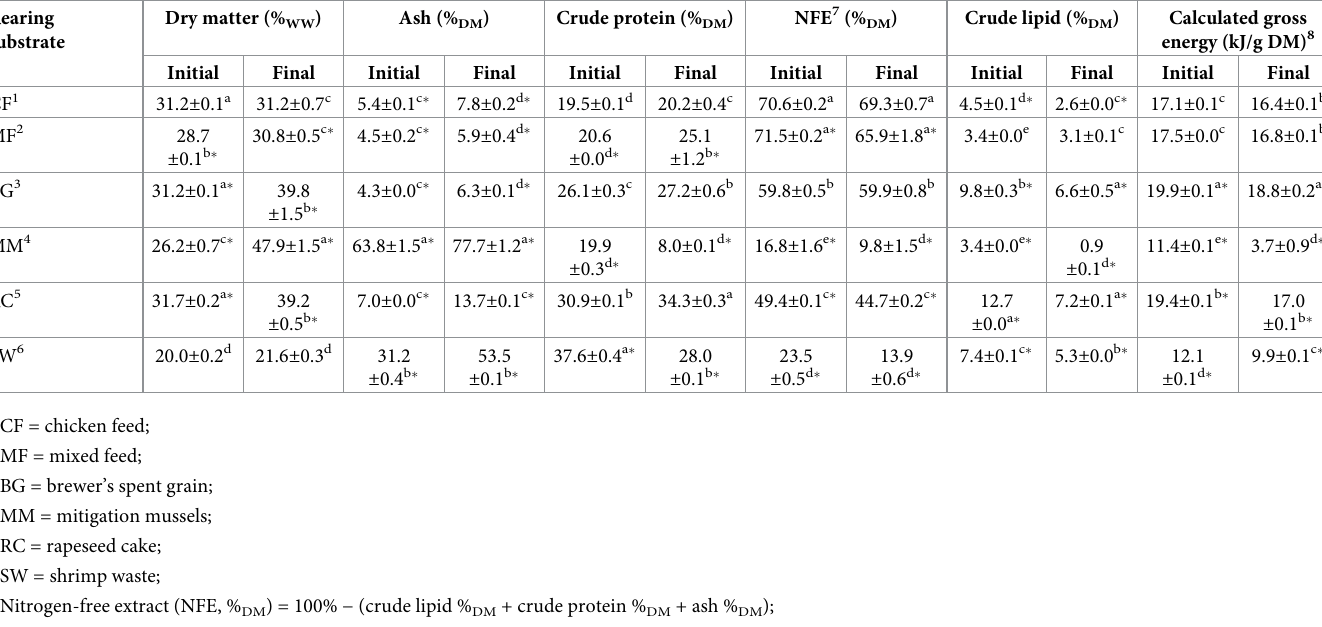
Table 2. Proximate composition of rearing substrates at the start (initial, t = 0 days) and the end of the trial (final, t = 7 days). All values are shown as mean ± standard error (SE; n = 3) for the percentage of wet weight (% WW ) or dry matter (% DM ). Dissimilar lower case superscript letters represent significant differences between means within the same column (p < 0.05) whereas asterisks indicate a significant difference between initial and final substrate composition for the indicated parameter. Rearing